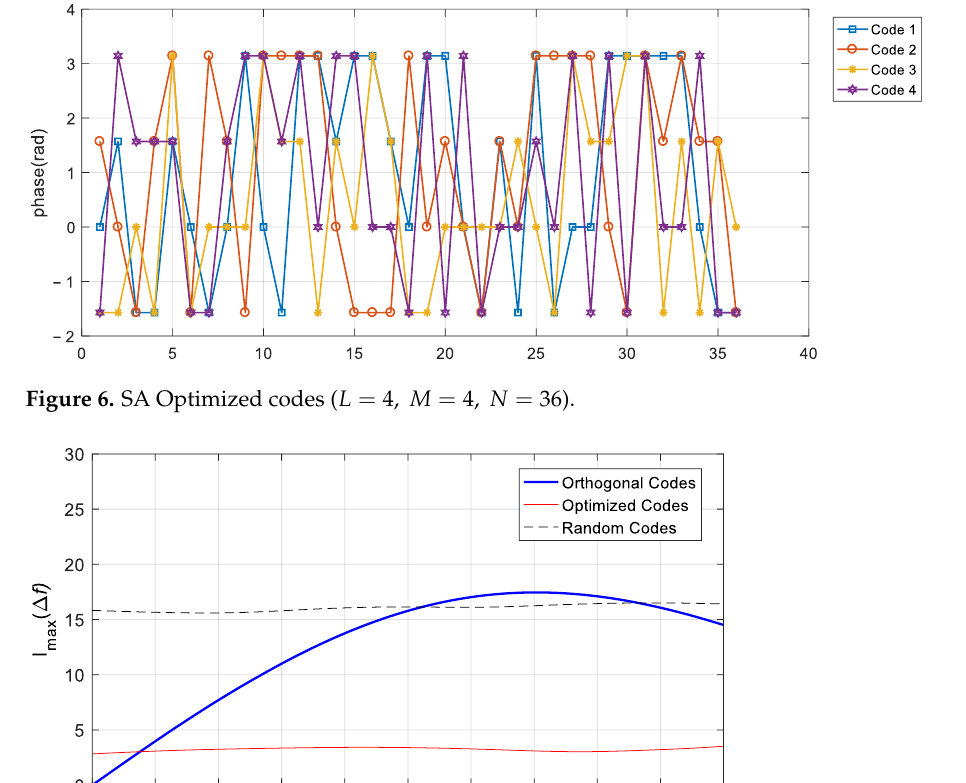
Figure 6. SA Optimized codes ( 𝐿 = 4,𝑀 = 4, 𝑁 = 36 ).